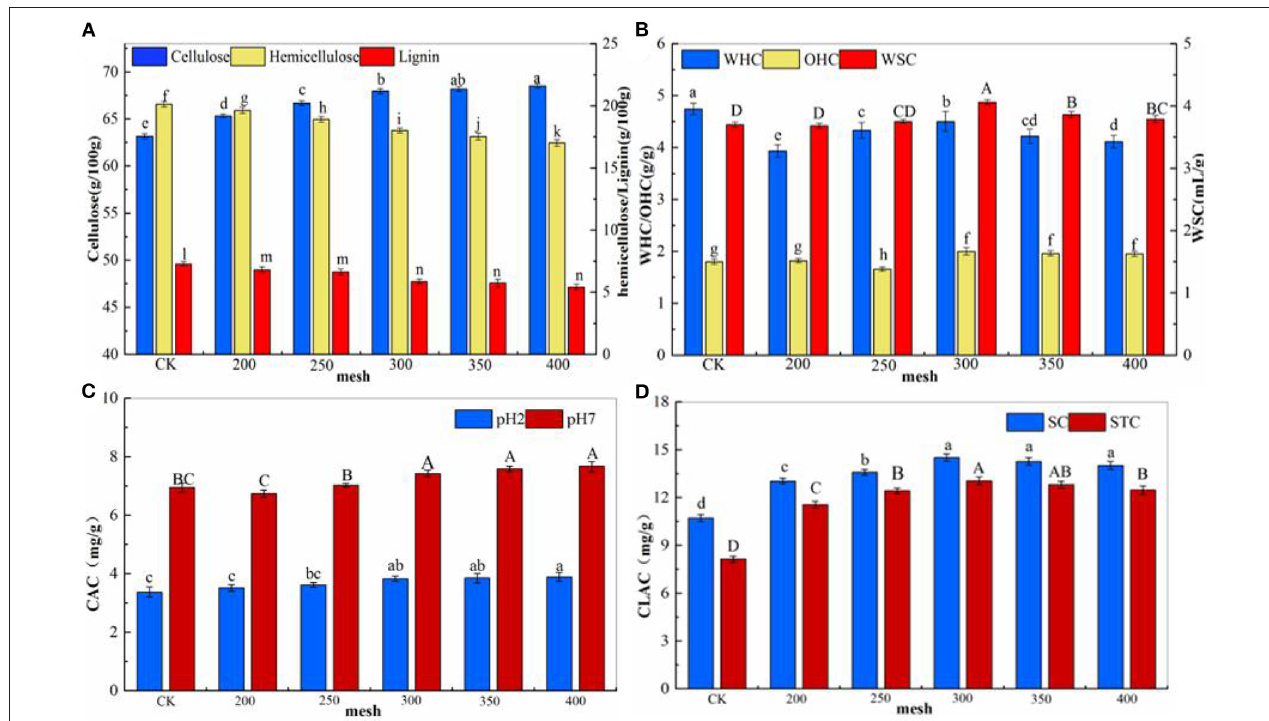
FIGURE 2 | Chemical compositions and physicochemical properties of different particle size IDF from corn bran. (A) Contents of cellulose, hemicellulose, and lignin, (B) WHC, OHC, and WSC of different particle size IDF from corn bran, (C) the CAC of different particle size IDF from corn bran, and (D) the CLAC of different particle size IDF from corn bran. Different letters of the same index showed a significant difference at p < 0.05.